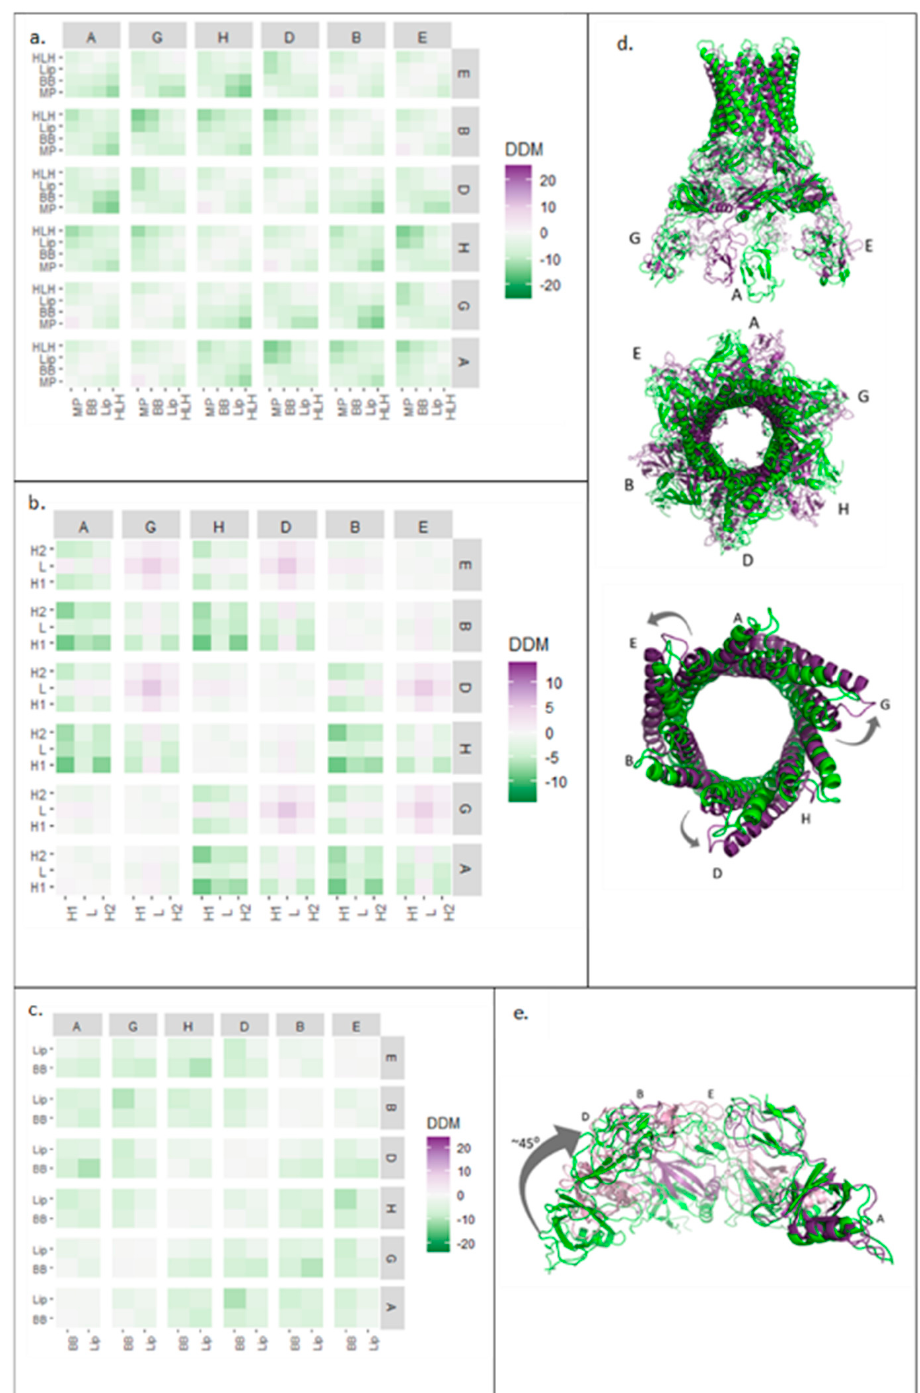
Figure 5. Block difference distance matrix (DDM) analysis of AcrA and HLH, BB, and lipoyl domains in hexameric assembly. ( a ) Average (DDM) changes for all AcrA domains in all six AcrA subunits. ( b ) Average DDM changes for HLH domain in all six AcrA protomers. ( c ) Average DDM changes for lipoyl and BB domains in all six AcrA subunits. ( d ) Resting (green, 5V5S) and transport (purple, 5NG5) structures of AcrA hexamer from the side (top) and above (middle) and of AcrA HLH domains from above (bottom). ( e ) BB and lipoyl domains from four of the six AcrA subunits aligned with subunit A in resting (green, 5V5S) and transport (purple, 5NG5) states. Subunit numbering from PDB: 5NG5. HLH: helix loop helix, BB: beta barrel.